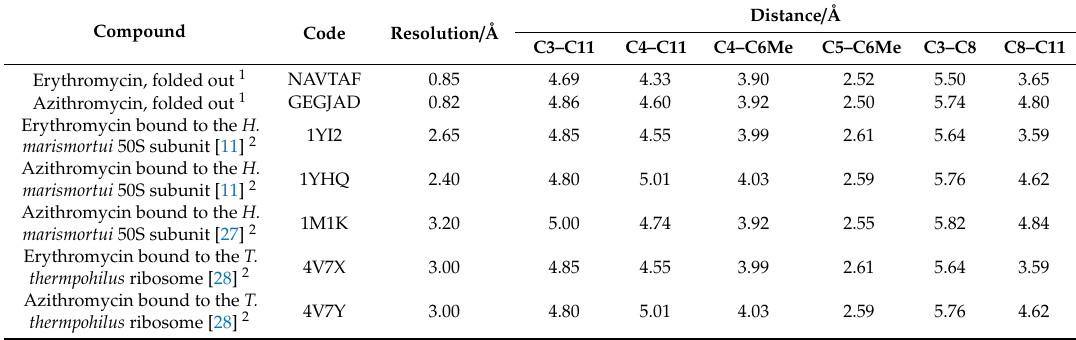
Table 1. Structural data for macrolides and their complexes with bacterial ribosomes in the crystal state. Compound